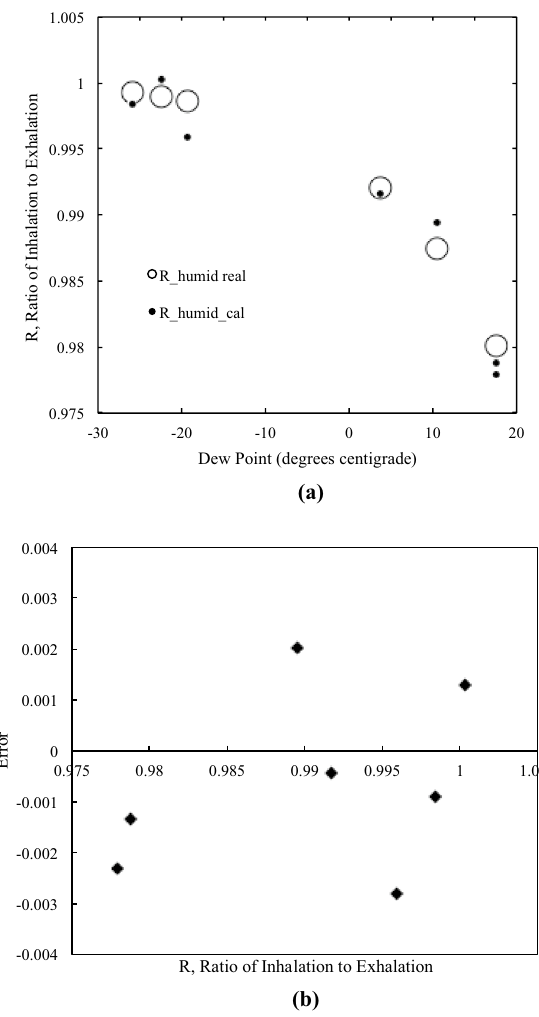
Figure 3. The Accuracy of R measurements. The molecular ratio of a dry gas to a humid gas was measured. The experiment was completed at room temperature (22–23 °C) and atmospheric pressure (1002–1006 hPa). ( a ) R is shown as a function of dew points calculated from the vapor pressure of water at these conditions. ( b ) Errors of the measurements were ± 0.003